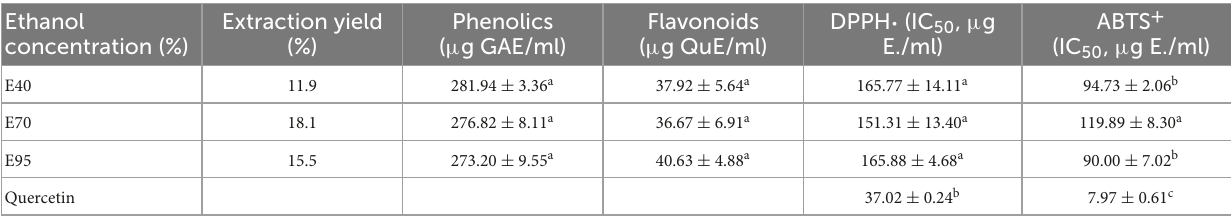
TABLE 1 Extraction rate, total phenolics, and total flavonoids content, and IC 50 values for DPPH · ABTS · + scavenging ability, and α -glucosidase inhibition of different PRA extracts. Ethanol Extraction yield concentration (%)